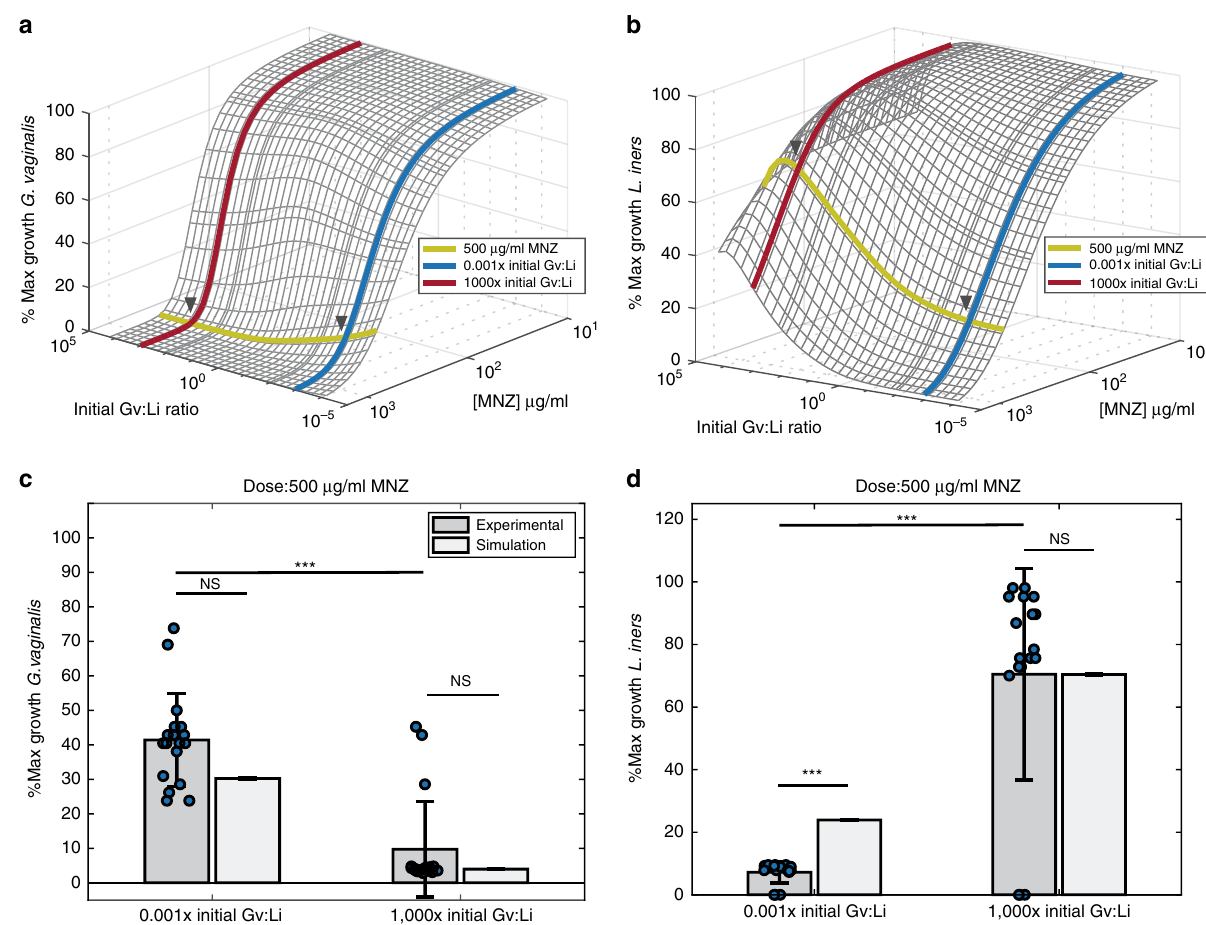
Fig. 2 A higher initial Gv:Li ratio improves MNZ treatment ef fi cacy. a Surface plot to illustrate predicted percent maximal growth of Gv ( z -axis) when concentration of MNZ ( x -axis) and the ratio of Gv:Li ( y -axis) are varied in simultaneously. Arrows indicate the concentration of MNZ and ratios of Gv:Li used for model validation. b Percent maximal growth of Li after simultaneous variation of MNZ dose and Gv:Li ratio. c , d Comparison of model simulations to experimental data for 500 μ g/ml MNZ at 1000× and 0.001× Gv:Li. Gv percent maximal growth 0.001× initial Gv:Li ratio and 1000× initial Gv:Li ratio experimental vs simulation, and experimental vs experimental p -values were p = 0.430, t = 0.809, df = 17; p = 0.680, t = 0.420, df = 17; p = 4.67 × 10 − 8 , t = 6.99, df = 34, respectively. Li percent maximal growth 0.001× initial Gv:Li ratio and 1000× initial Gv:Li ratio experimental vs simulation, and experimental vs experimental p -values were p = 1.43 × 10 − 5 , t = 6.00, df = 17; p = 0.726, t = 0.357, df = 17; p = 3.29 × 10 − 9 , t = 7.91, df = 34, respectively. Data are presented as mean ± SD, n = 18 independent, biological replicates for each initial ratio, asterisks indicate signi fi cance as: * p < 0.05, ** p < 0.01, *** p < 0.001 without adjustment for multiple comparisons, unpaired two-sided t -test. Source data are provided as a Source data fi